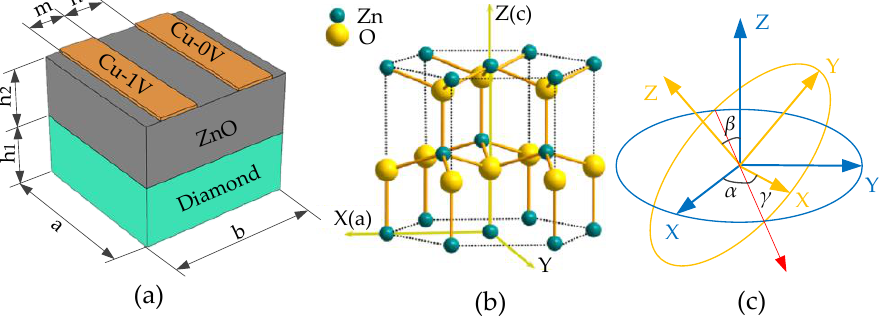
Figure 3. Structural unit model of phonon piezoelectric device and ZnO microstructure. ( a ) Structural unit model of phonon piezoelectric device; ( b ) the crystal structure of ZnO; ( c ) a plot of rotation coordinate of ZnO.